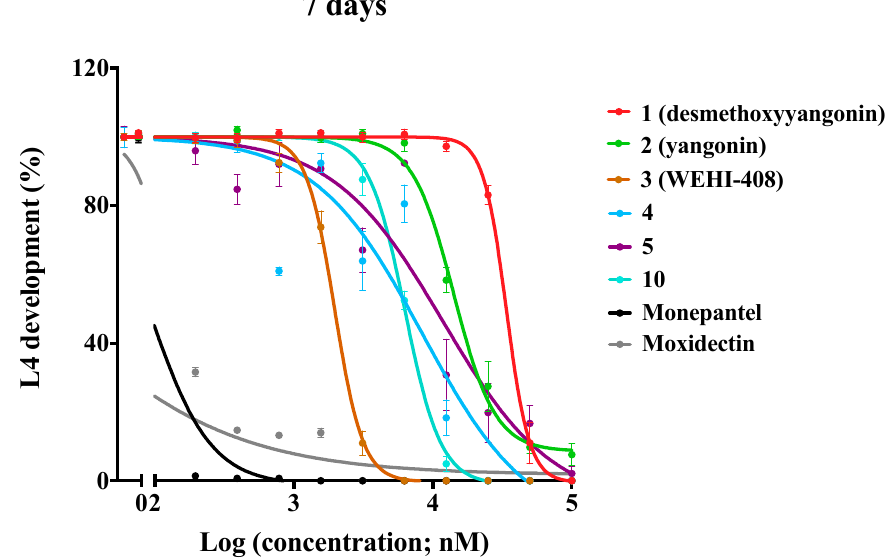
Figure 2. The activity of desmethoxyyangonin, yangonin and selected analogues ( 3 , 4 , 5, and 10 ) against Haemonchus contortus in the larval development assay (conducted over 7 days). Dose-response curves for the two parent kavalactones ( 1 and 2 ) and four analogues ( 3 , 4 , 5 and 10 ) for developmental inhibition in comparison to monepantel or moxidectin. Information on compounds is given in Table 1.